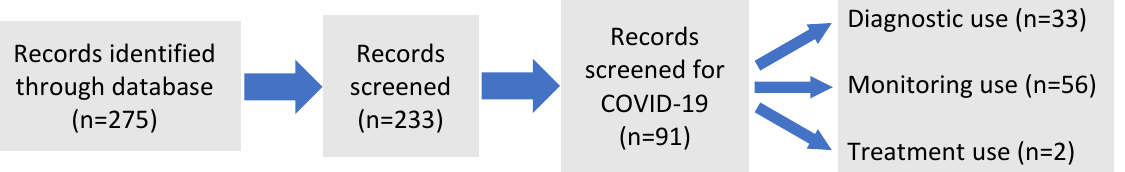
Figure 1. Diagram of systematic selection by use.